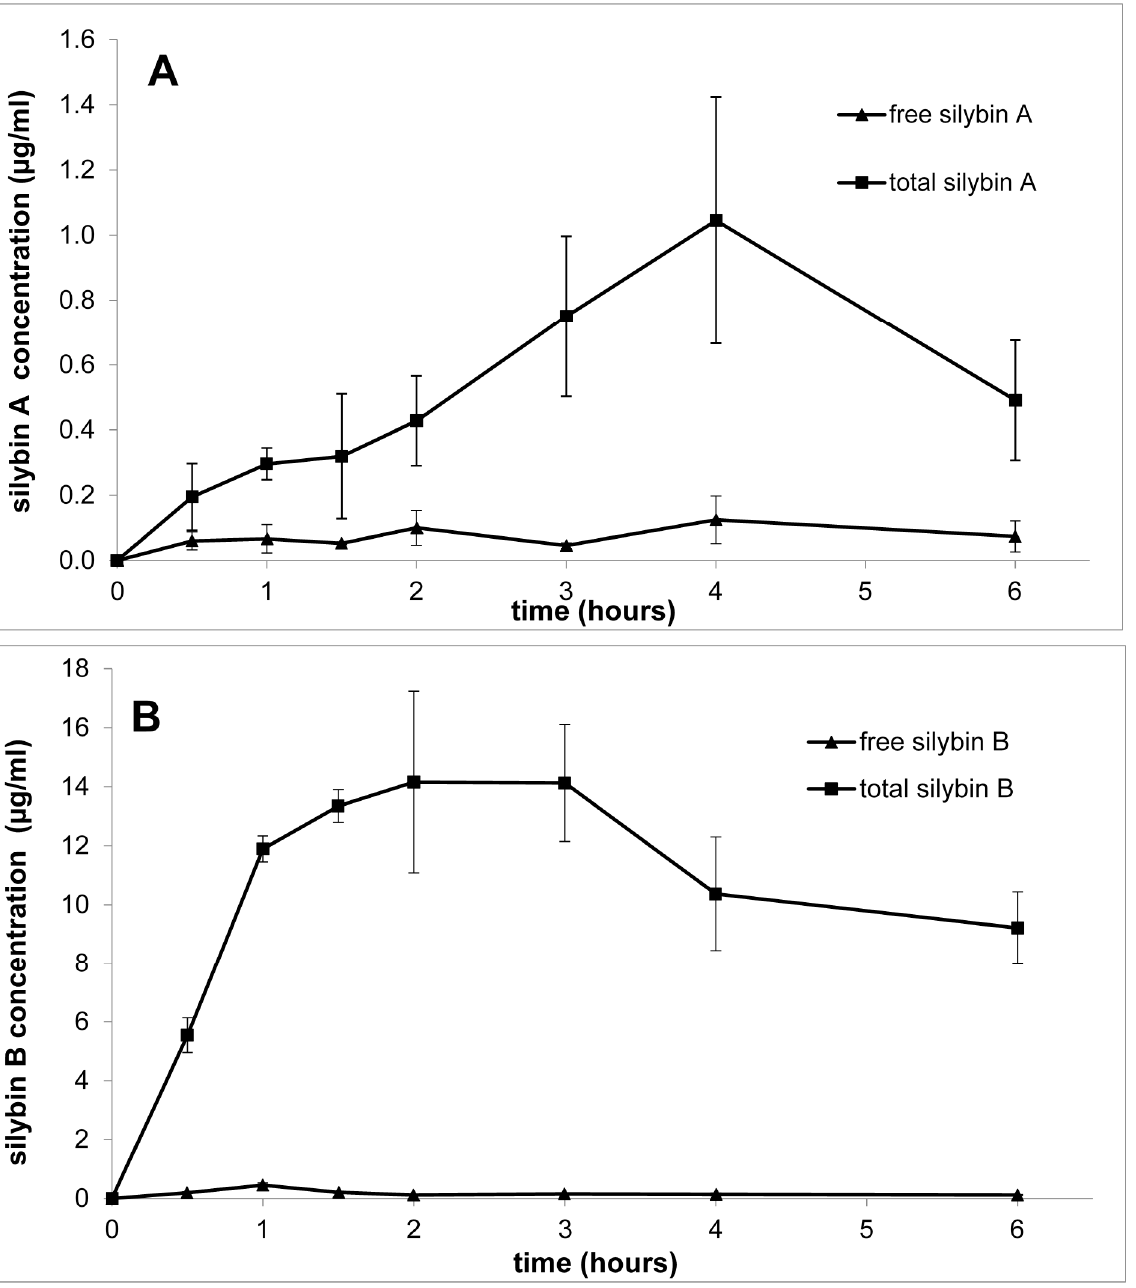
Figure 9. ( A ) Plasma concentration-time profile of free (unconjugated) and total silybin A in rats; ( B ) free and total silybin B after gastric administration of a single dose of 200 mg-kg –1 body weight (mean of three animals, error bars—standard deviation) [84].